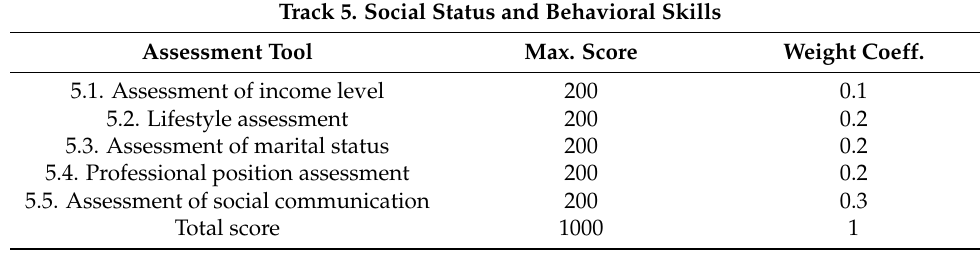
Table 5. Assessment of human capital components (Track